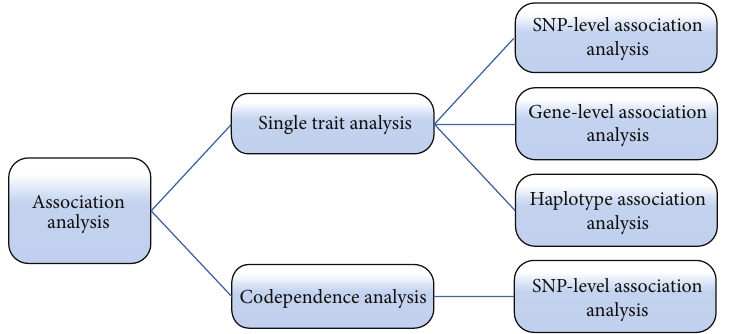
Figure 1: The pipeline of the association